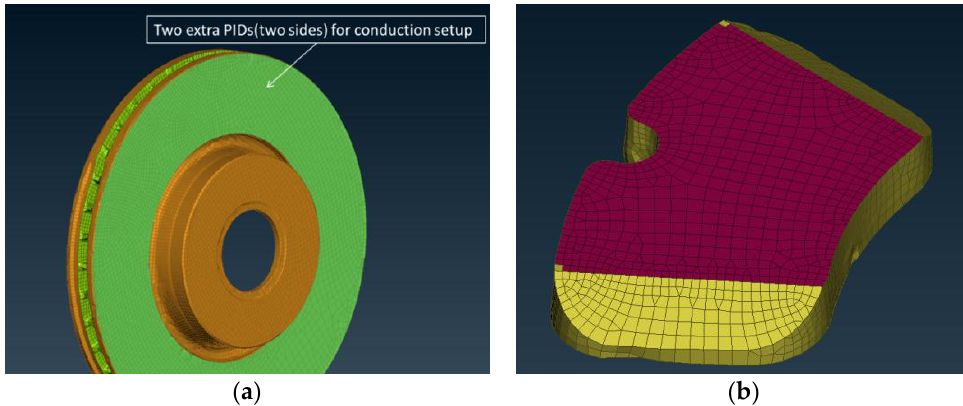
Figure 5. Extra surface part IDs (PIDs) assigned for brake disc in green ( a ), and the brake pad in purple ( b ).